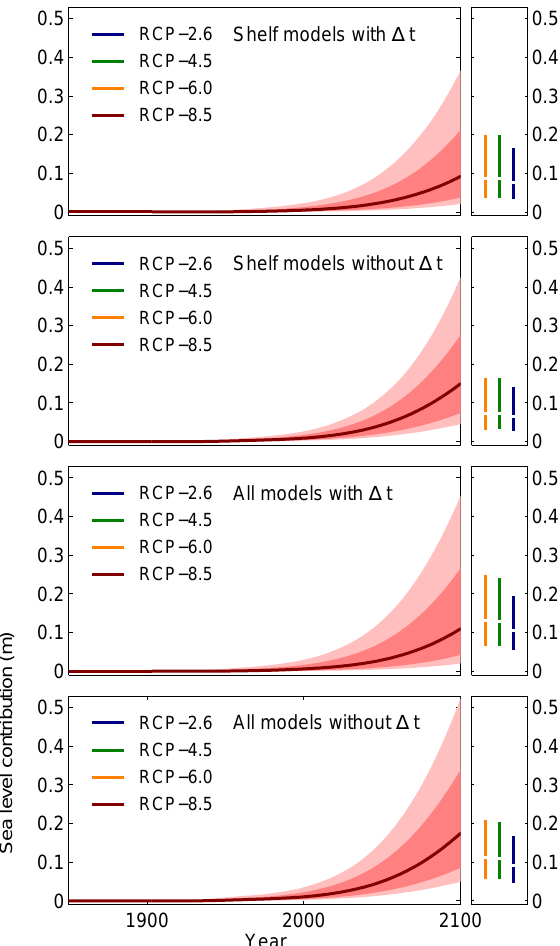
Figure 11. Uncertainty range of contributions to global sea level from basal ice-shelf melt induced ice discharge from Antarctica including climate-, ocean- and ice-sheet model uncertainty. Lines, shading and colour coding as in Fig. 8. Estimates with and with- out the time delay between global mean surface air temperature and subsurface ocean temperature (Tables 2–5) are presented. Shelf models are those ice-sheet models with explicit representation of ice